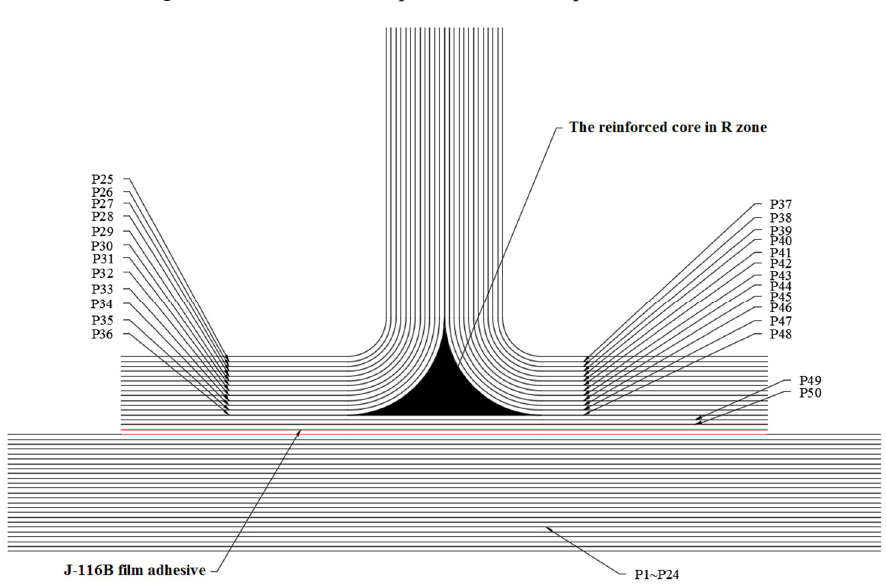
Figure 1. The aircraft composite-reinforced panel (unit: mm).